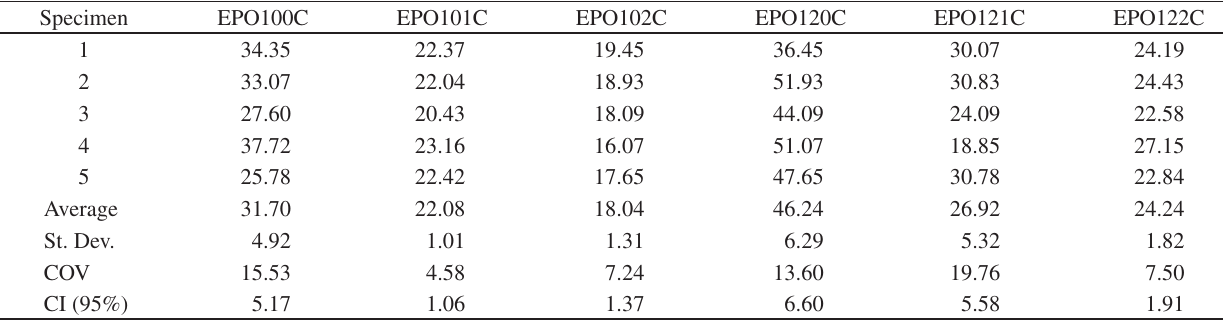
Table 3. Compressive strength test results of textile polymer concrete (MPa).